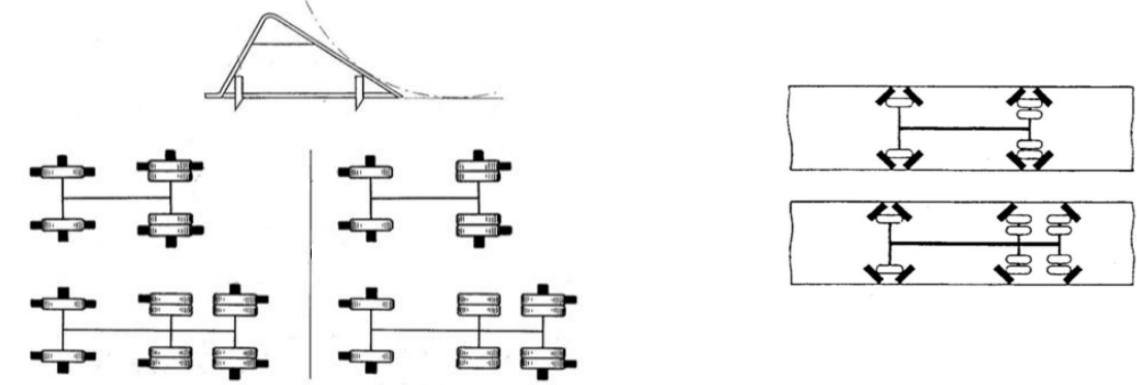
Figure 3. Examples of the arrangement of wedges under the wheels of a road vehicle